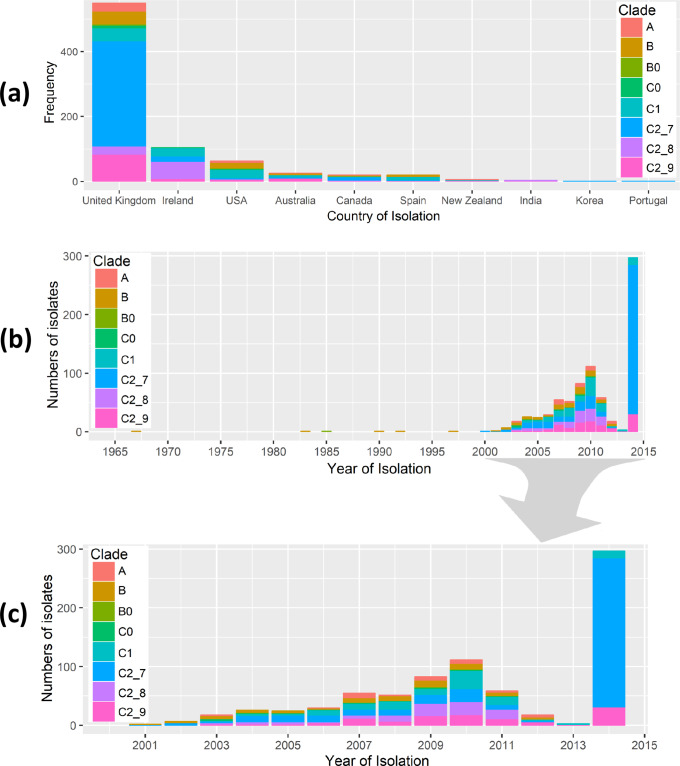
Geographical and temporal distribution of global ST131 isolates. ST131 from the eight subclades (n=794) showed differing frequencies across country of origin (a) and year of isolation (b and c). The subclades were A (n=33), B (n=70), B0 (n=5), C0 (n=14), C1 (n=111), C2_7 (n=362), C2_8 (n=86) and C2_9 (n=113). The ST131 isolates were sampled during 1967–2014. The figures were generated using the ggplot2 and ggjoy packages in R v.3.5.2.